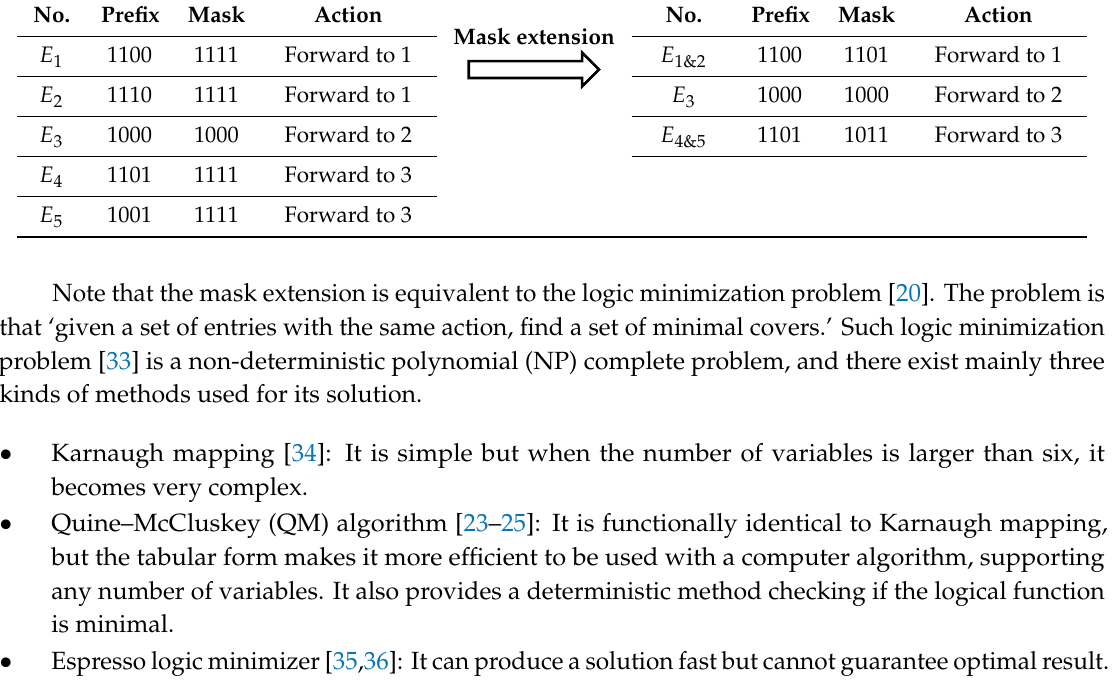
Algorithm 1. Entry aggregation with mask extension